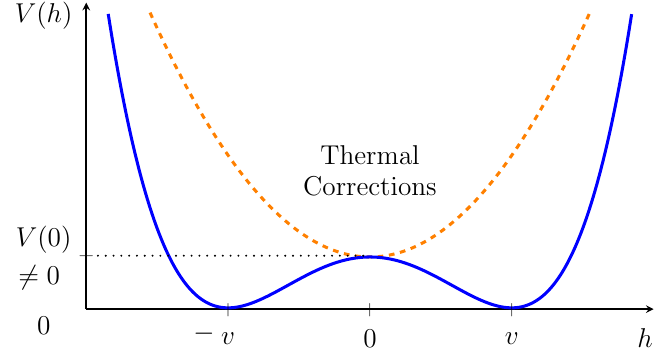
Figure 1 . The potential for the Higgs (1.1) with the choice V ( v ) = 0. When T > T EW thermal corrections will prevent spontaneous symmetry breaking and lead to a convex potential (the orange dashed curve). When T < T EW the potential takes the mexican hat shape (the blue curve). corrected potential (orange dashed curve in (cid:12)gure 1) acquires a Mexican hat shape (blue curve in (cid:12)gure 1) leading to a change in vacuum energy that is some 10 55 times larger